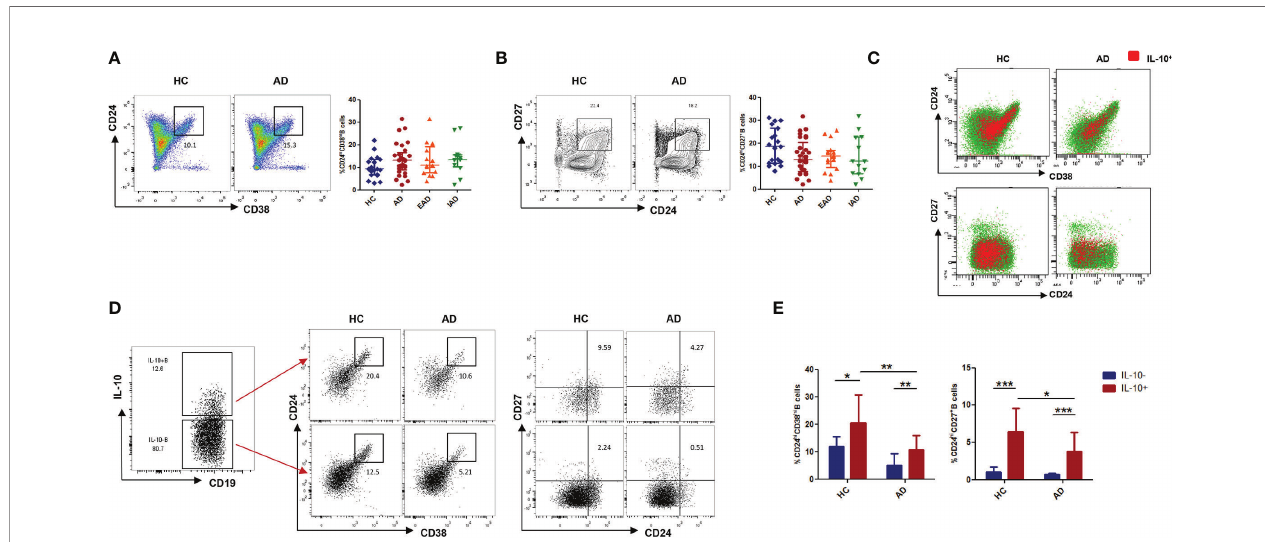
FIGURE 2 | The phenotype of IL-10 + Breg cells in peripheral blood from patients with AD. (A, B) The percentages of CD19 + CD24 hi CD38 hi transitional B cells and CD19 + CD24 hi CD27 + memory B cells in patients with AD are normal (HC: n = 19; patients with AD: n = 29). (C) Distribution of IL-10 + B cells within B cell subsets, de fi ned by expression of CD24/CD38 and CD24/CD27, in patients with AD and in healthy controls. (D, E) CD24 hi CD38 hi and CD24 hi CD27 + cells were more frequent in IL-10 + B cells than in IL-10 - B cells (HC: n = 11; patients with AD: n = 13). Data are represented as median and interquartile range. *P < 0.05, **P < 0.01, and ***P < 0.001 (Mann-Whitney U